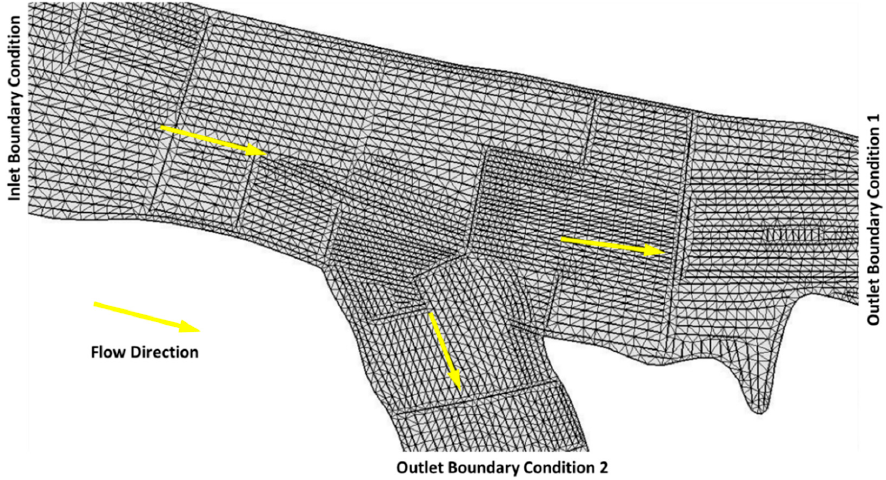
Figure 5. Unstructured grid of the Tigris branching channel.